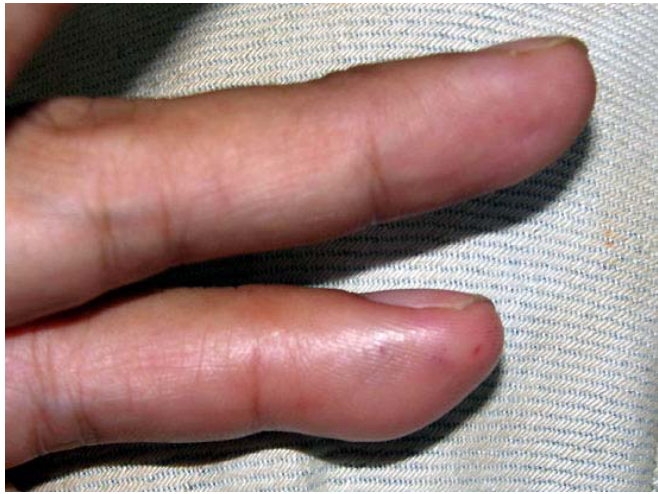
Figure 1: Beginning of swelling 12 min after the bite by Ithycyphus miniatus (Case 1). The enlarged posterior maxillary teeth of the snake were embedded into the ventral surface of the distal segment of the left ring finger for 60 s during the bite.